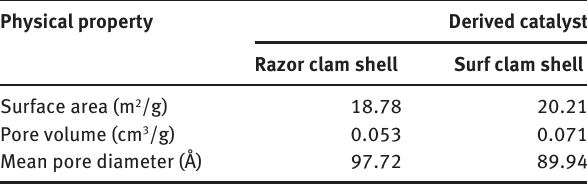
Table 2: The physical properties of waste shell-derived